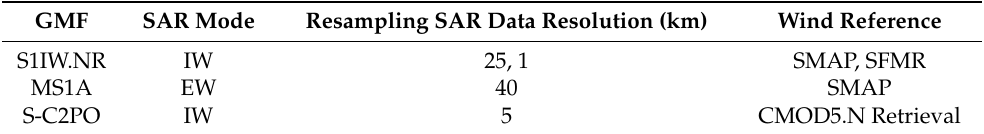
Table 2. Comparison of data sources of the proposed S1IW.NR model, the MS1A model, and the S-C2PO